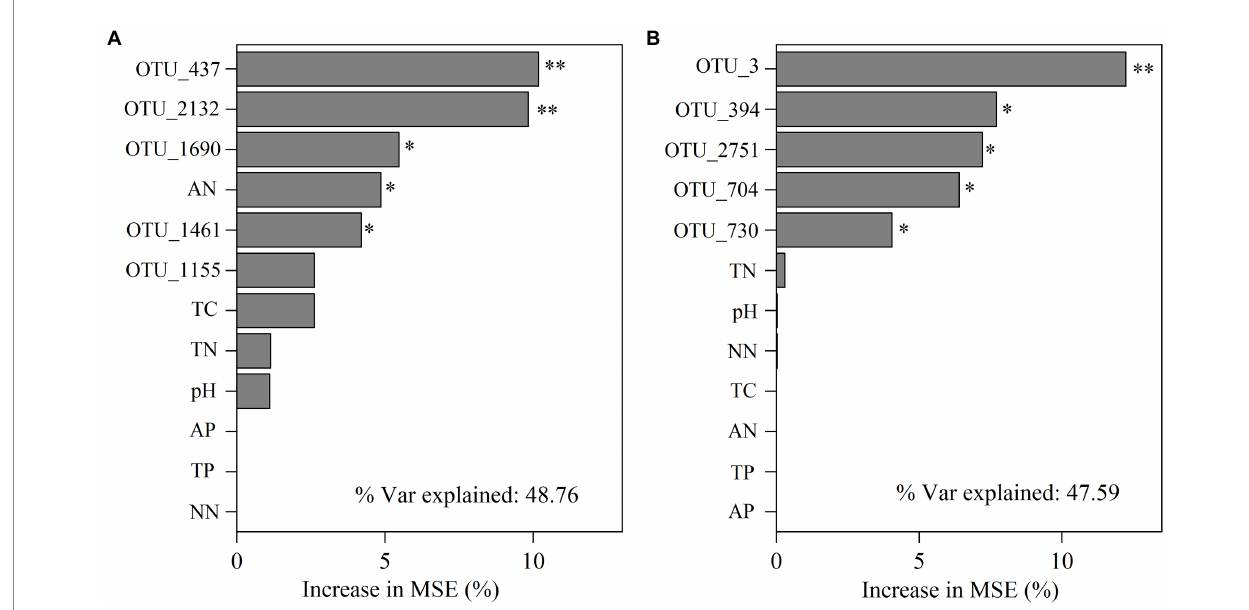
FIGURE 6 Mean predictor importance of the relative abundances of keystone taxa and edaphic factors on microbial functions of A . palmeri (A) and native (B) rhizosphere soils. The contribution (% of increased mean square error) is calculated based on random forest analyses. Higher MSE% values imply more important predictors (* p < 0.05, ** p < 0.01). TN, total nitrogen; TC, total carbon; TP, total phosphorus; AN, ammonium nitrogen; NN, nitrate nitrogen; AP, available phosphorus.